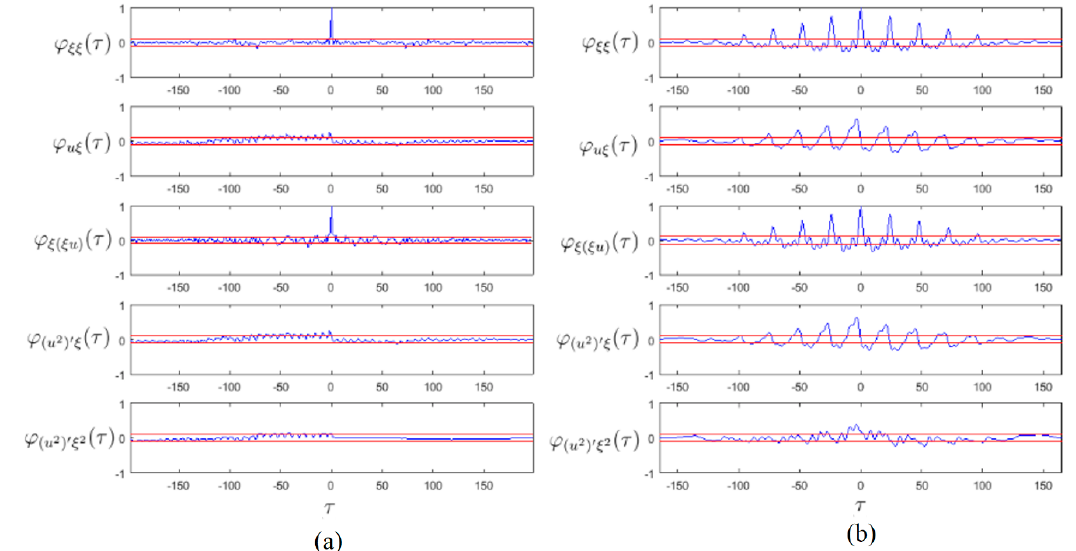
Figure 11. Correlation tests for ( a ) Polish dataset and ( b ) Brazilian dataset.